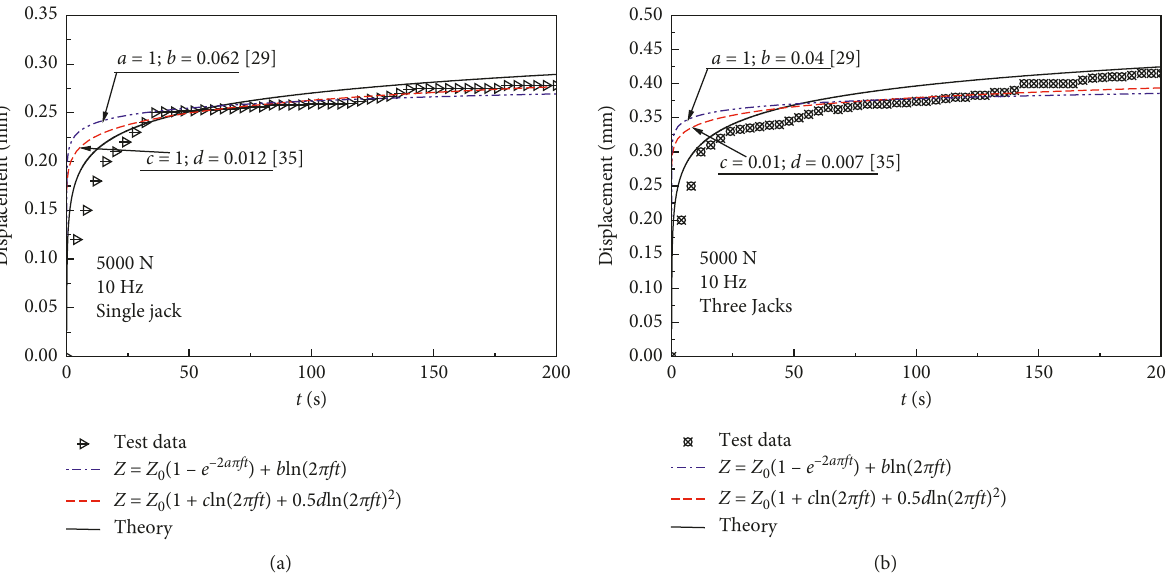
Figure 10: Variation in the displacement versus time curve (gravel): (a) single jack and (b) three